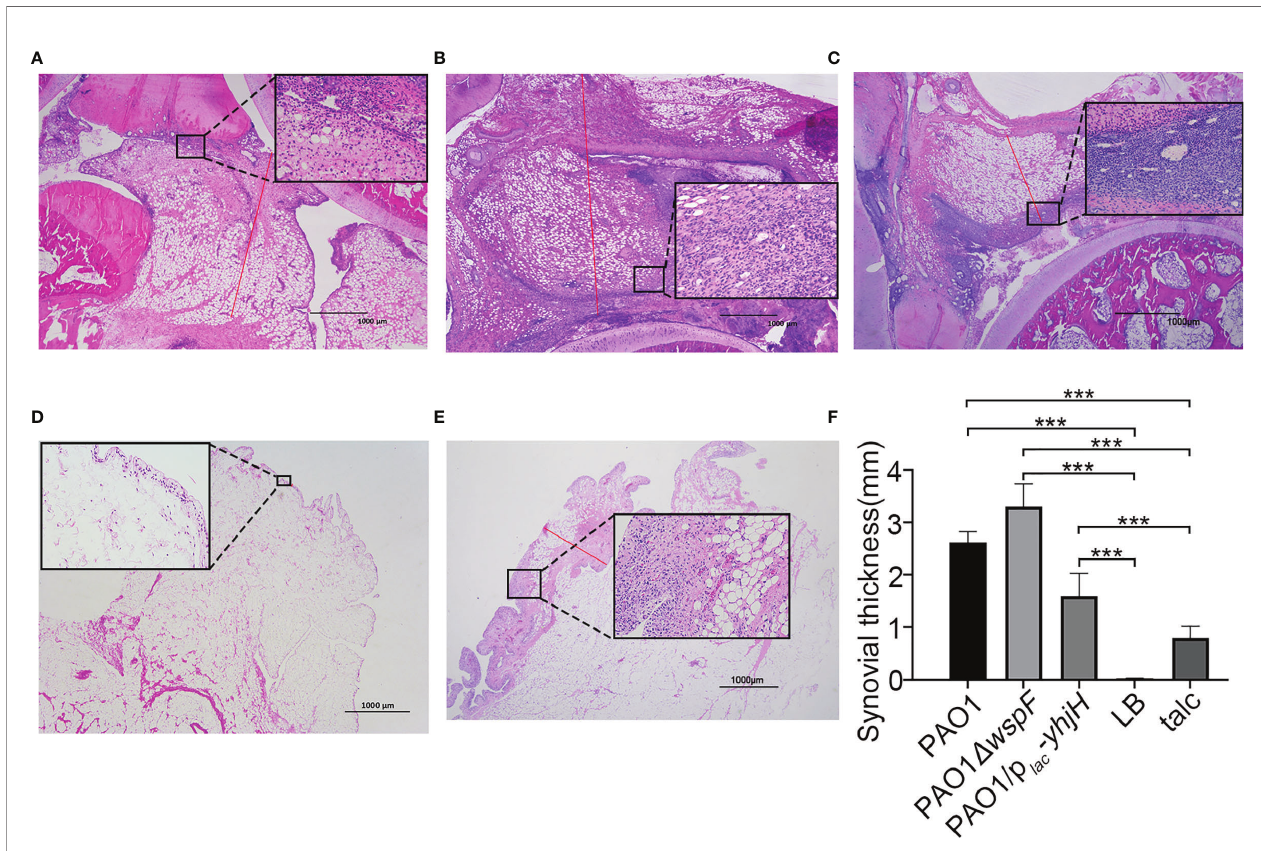
FIGURE 3 | The morphological changes of the synovial membrane 7 days after injection. (A) Thickening of the synovial membrane with in fl ammatory cell in fi ltration in the PAO1 infection group. The length of the red line represents the measured synovial thickness (H&E staining, ×20). Morphological changes of the synovial membrane marked and enlarged with a black box (H&E staining, ×200). (B) In fi ltration of a marked amount of in fl ammatory cells resulted in signi fi cant thickening of the synovial membrane in the PAO1 D wspF group than that in the PAO1 group. (C) The synovial membrane was slightly thickened with only mild in fl ammation in the PAO1/p lac -yhjH group. (D) Fewer in fl ammatory cells present in the LB control group. (E) Severe aseptic in fl ammation in the talc control group. (F) The synovial membrane thickness of each group. Results displayed as the mean ± SD. *** p < 0.001 versus LB and talc control groups (control group). ANOVA test was used to